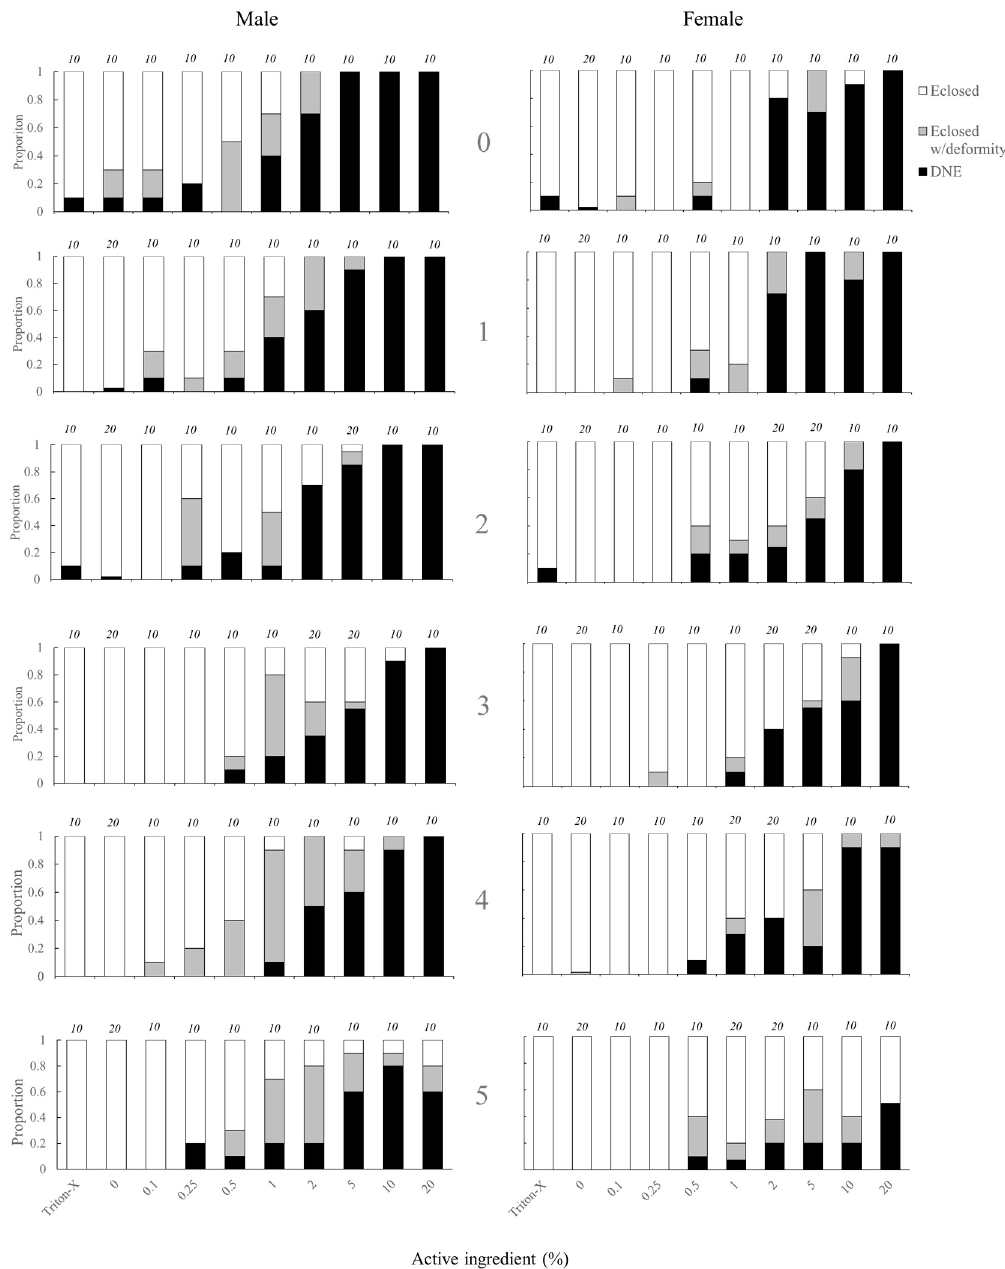
Figure 1. Age-specific proportions of C. fumiferana eclosing to an adult, eclosing to an adult with a deformity, or not eclosing (‘did not eclose’, DNE) following treatment with Triton-X, water, or various doses of tebufenozide (Mimic ™ ). Age (indicated by 0, 1, 2, 3, 4, and 5 within figure) represents the number of days after pupation at which the individual was treated. Numeric values above data bars represent the number of individuals (‘n’) included in each treatment x age